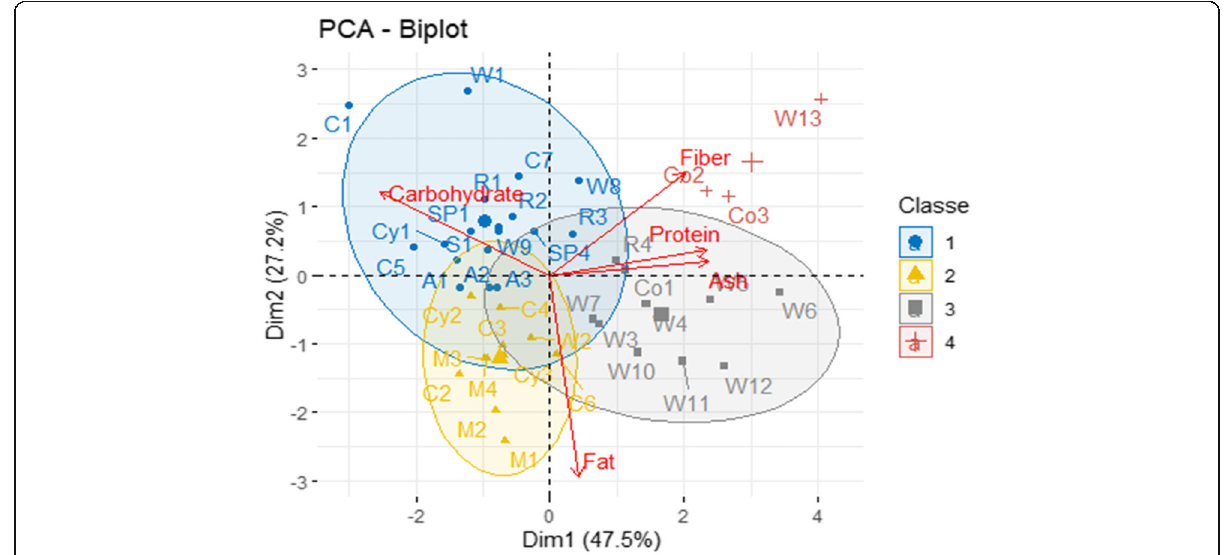
Fig. 2 PCA biplot of the proximate composition to 42